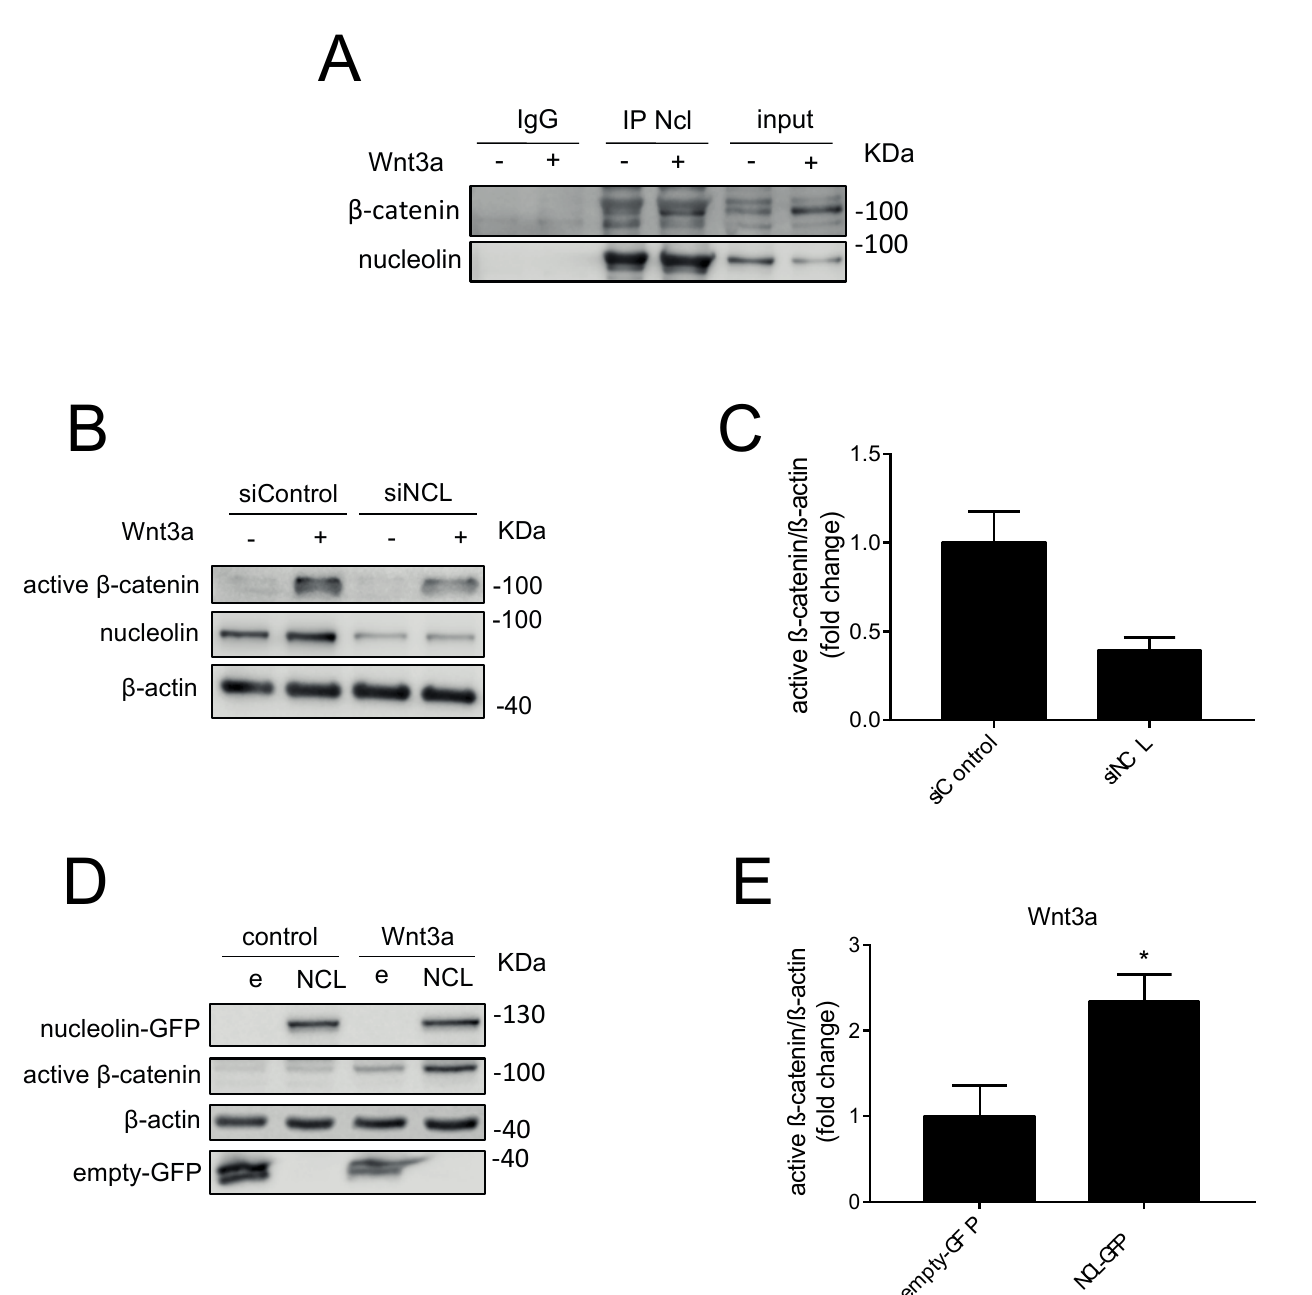
Figure 3. Nucleolin promotes β -catenin activation. ( A ) MIA PaCa-2 and Panc-1 cells were stimulated or not with Wnt3a-CM for 3 h. Western blotting analysis of nucleolin immunoprecipitation (IP) or control IgG performed from the extranuclear fraction is shown. Anti-nucleolin confirmed the performance of the immunoprecipitation and anti- β -catenin the interaction between these two proteins. ( B ) MIA PaCa-2 cells were transfected with 20 nM siNCL or with a control siRNA for 72 h and stimulated with or without Wnt3a-CM for 3 h before lysis. ( D ) MIA PaCa-2 cells were transfected with GFP-NCL (NCL) and GFP-empty. (e) plasmids for 72 h. Cells were stimulated with or without Wnt3a-CM for 3 h before lysis. Western blotting analysis exhibited a stronger band of active β -catenin in cells with higher nucleolin expression than those with basal levels of the protein ( n = 3 experiments). ( C , E ) Western blotting quantification of active β -catenin is shown. Active β -catenin was analyzed by using an antibody against non-phosphorylated form of β -catenin (two-tailed Mann–Whitney U-test, n = 3 and n = 4 experiments, * p <